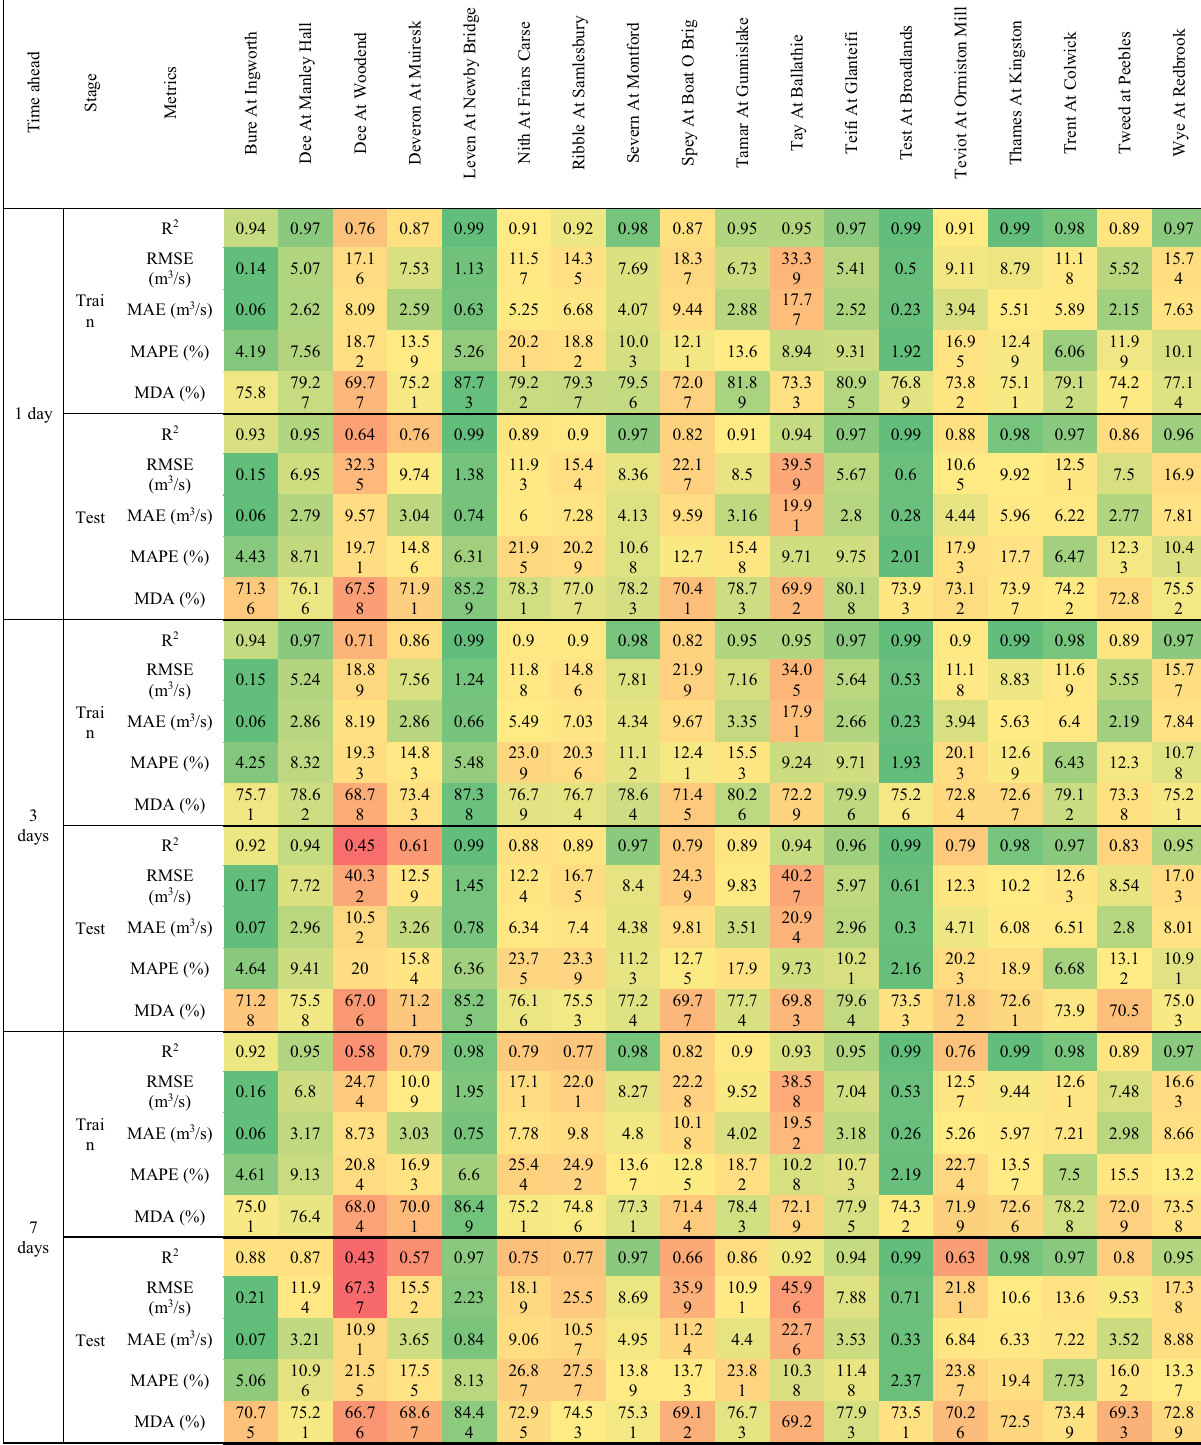
Table 3. Evaluation metrics for NARX